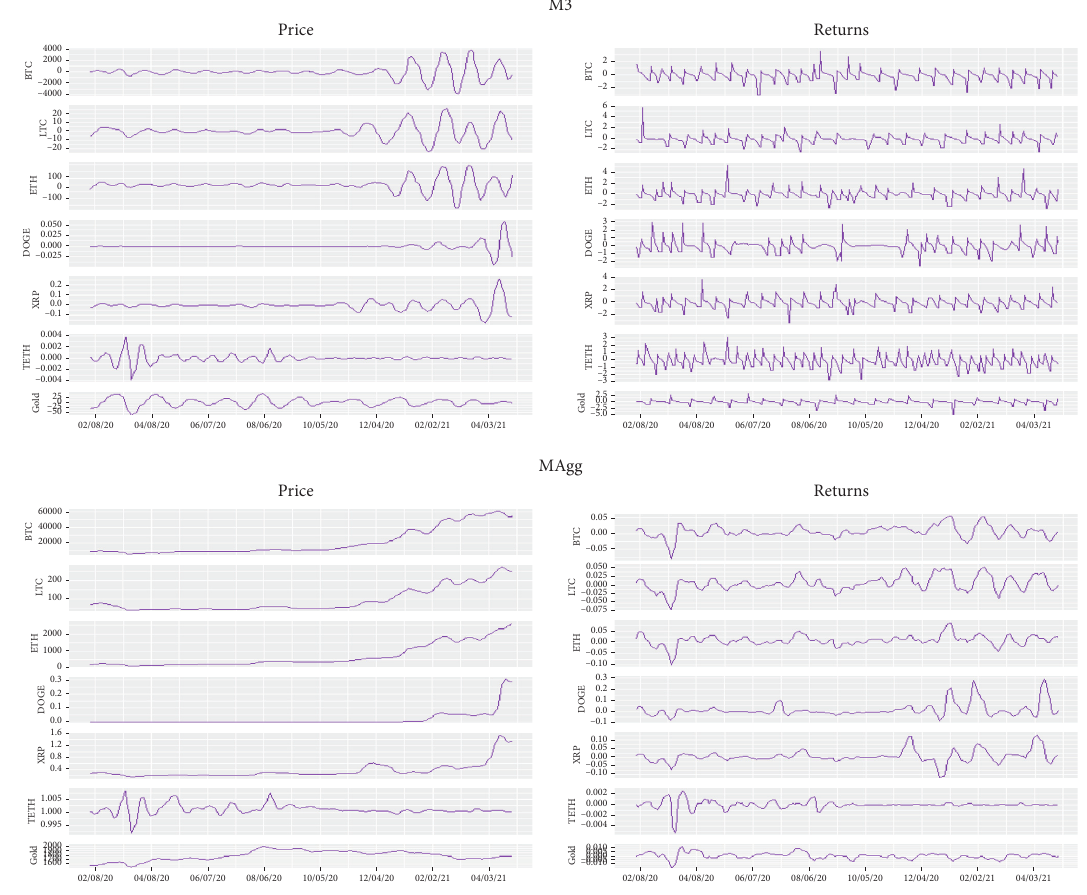
Figure 1: Plots of prices and returns series. Note: the time-varying prices and returns of cryptocurrencies and gold for both the original (signal) and the decomposed series (M1, M2, M3, and MAgg). The decomposed series reveal the investment horizons, where M1 indicates short-term; M2 and M3 depict medium-term, whereas MAgg shows long-term. At the early part of 2020, the price series for most markets trend upwards, after a downward spike. That is, the prices depict rapid